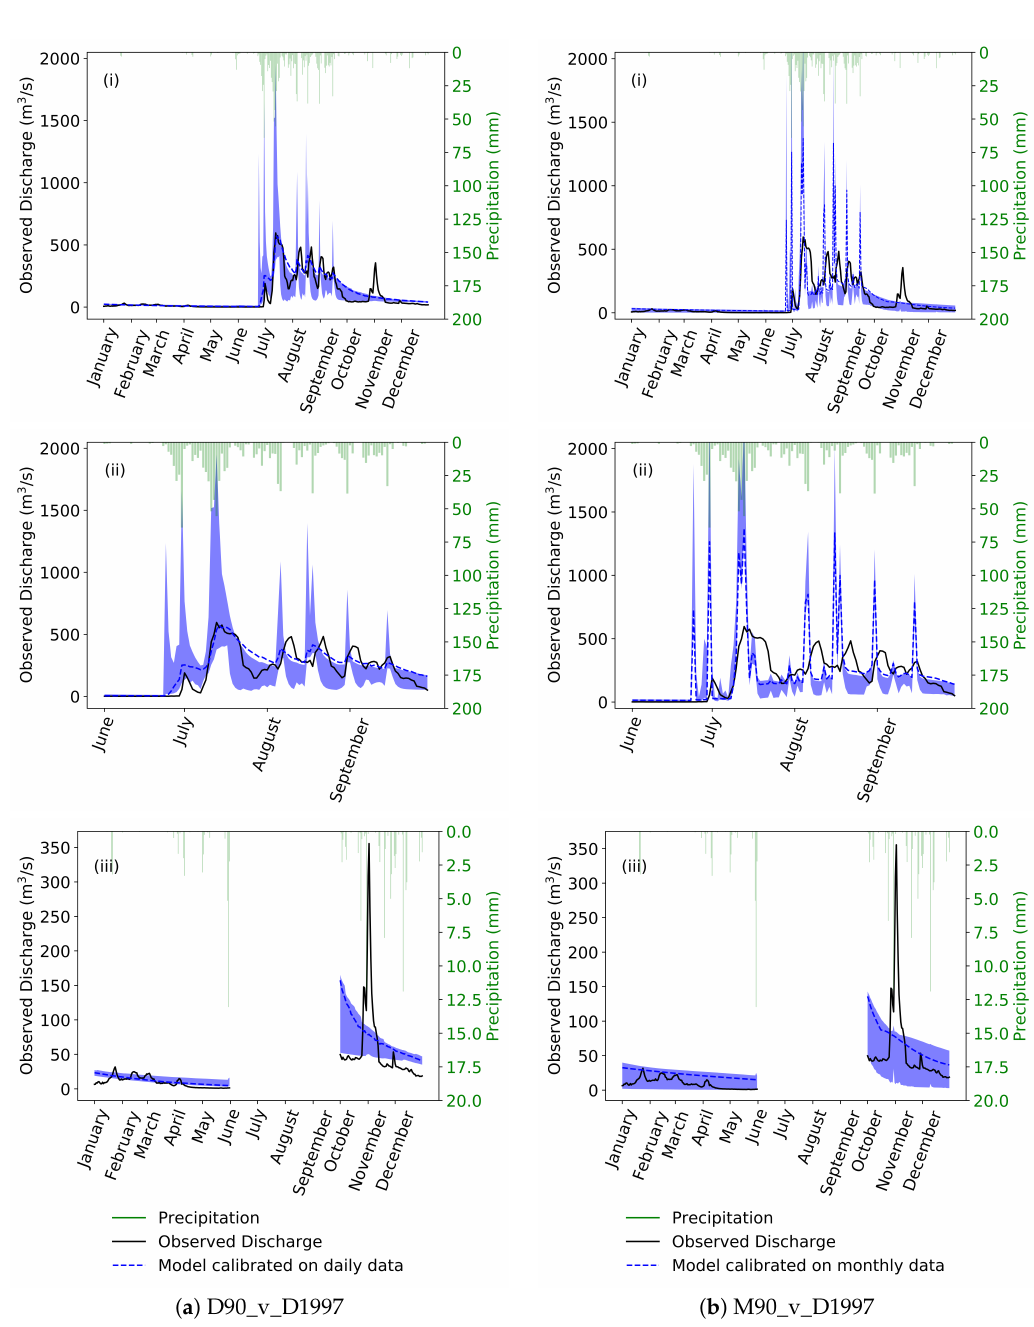
Figure 3. Time-series comparison of SWAT simulated and observed basin outlet daily discharges for the year 1997, developed using calibrated parameter sets of the calibration cases ( a ) D90 (D90_v_D1997) and ( b ) M90 (M90_v_D1997), illustrated for different periods: (i) full year, (ii) monsoon (June–September), and (iii) non-monsoon (data only presented for January–August and October–December). The blue band indicates the 95PPU range of simulated discharge; the dotted line indicates the simulation corresponding to the ‘best’ parameter set; and observations are represented by the solid